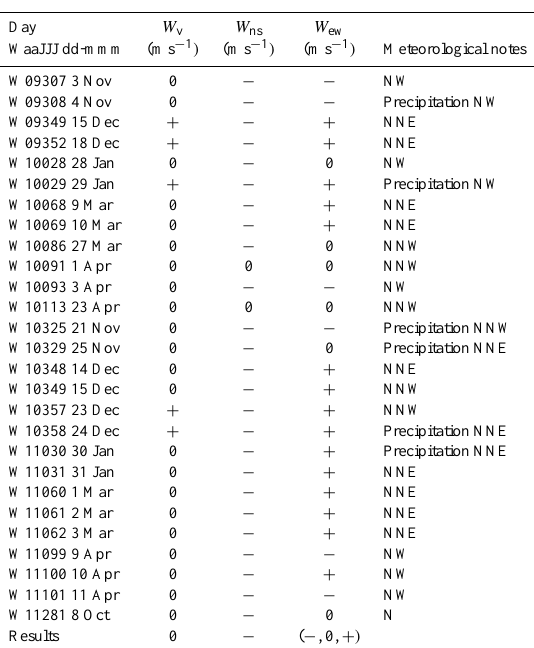
Table 2. Trend of the north case